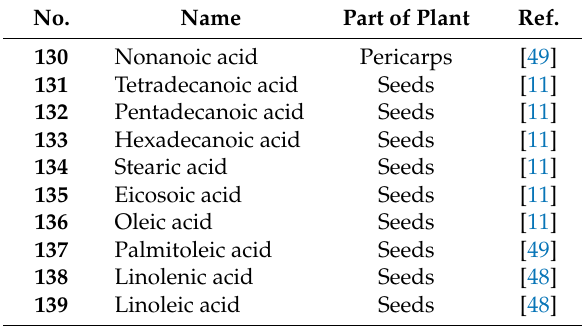
Table 5. Fatty acids isolated from Z. bungeanum ( 130 – 139